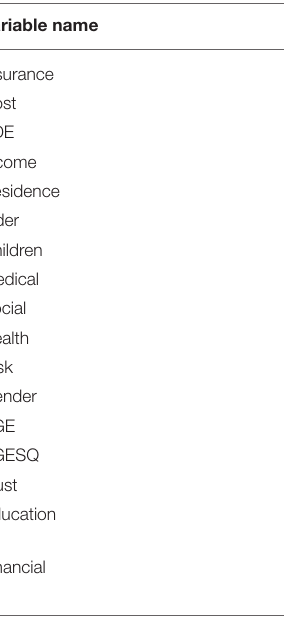
TABLE 1 | Variable